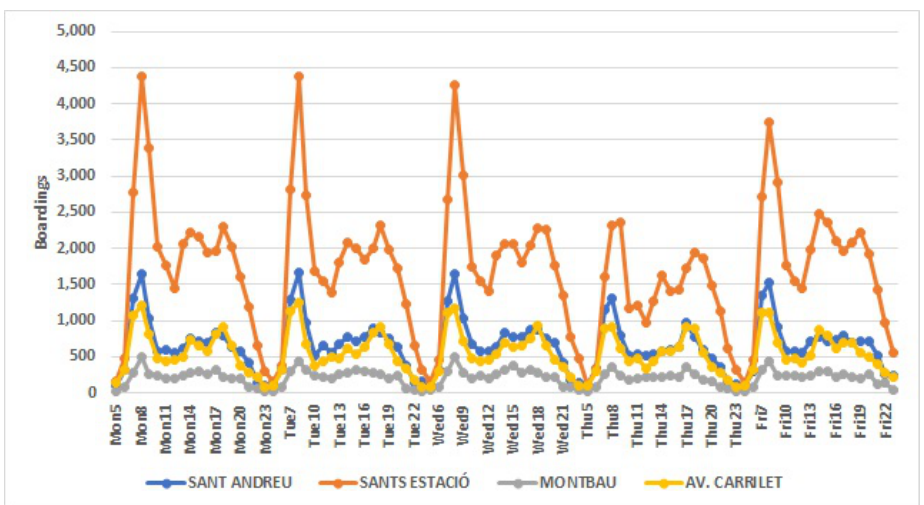
Figure 14. Pattern of boarding in stations of Cluster 2 (weekdays).